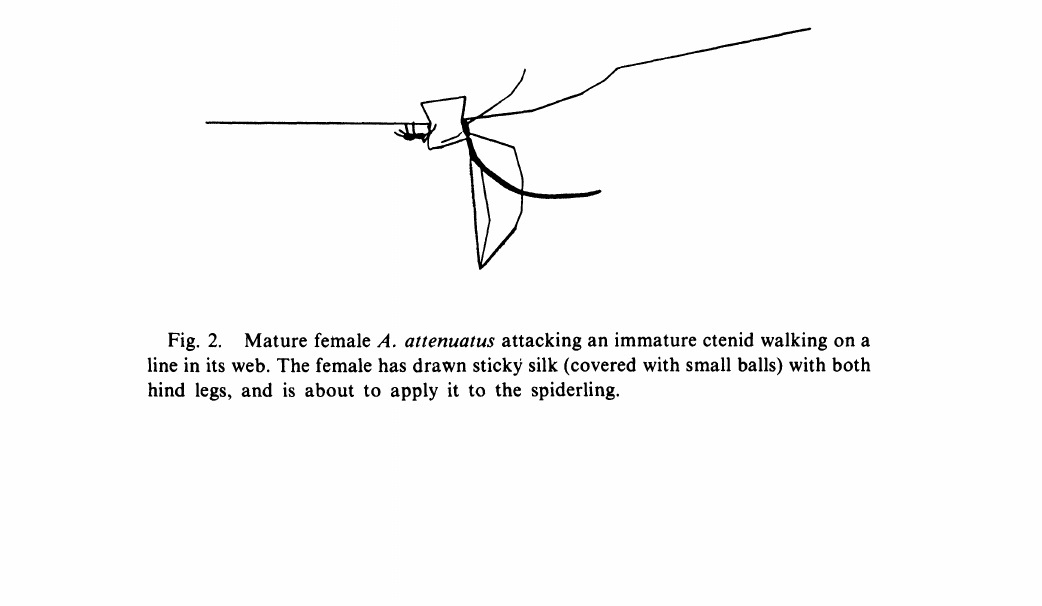
Fig. 2. Mature female A. attenuatus attacking an immature ctenid walking on a line in its web. The female has drawn stick3 silk (covered with small balls) with both hind legs, and is about to apply it to the